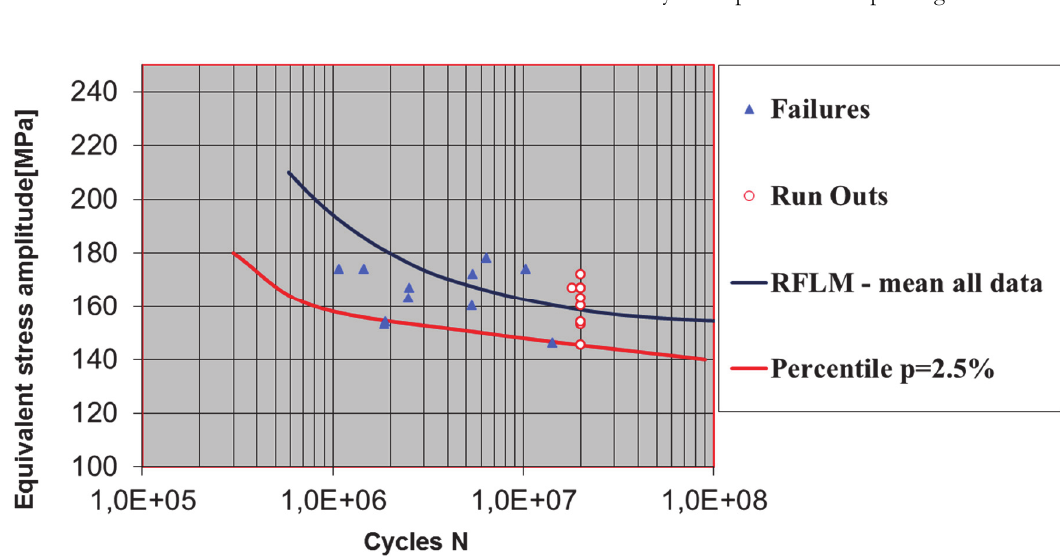
Figure 5: RFLM Analysis of both test series based on applied Dang Van equivalent